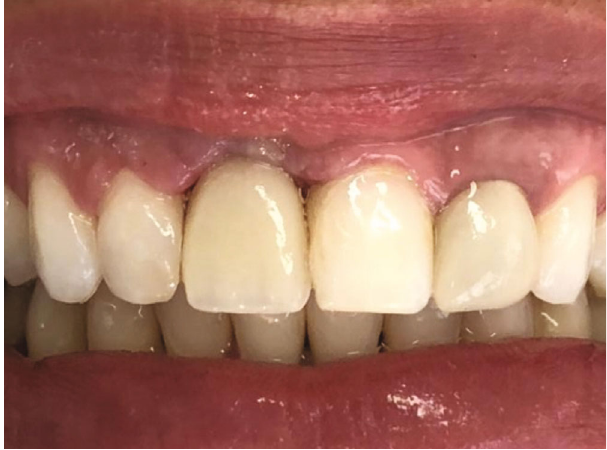
Figure 7: Placement of the temporary abutment on the implant, after implant uncovering.